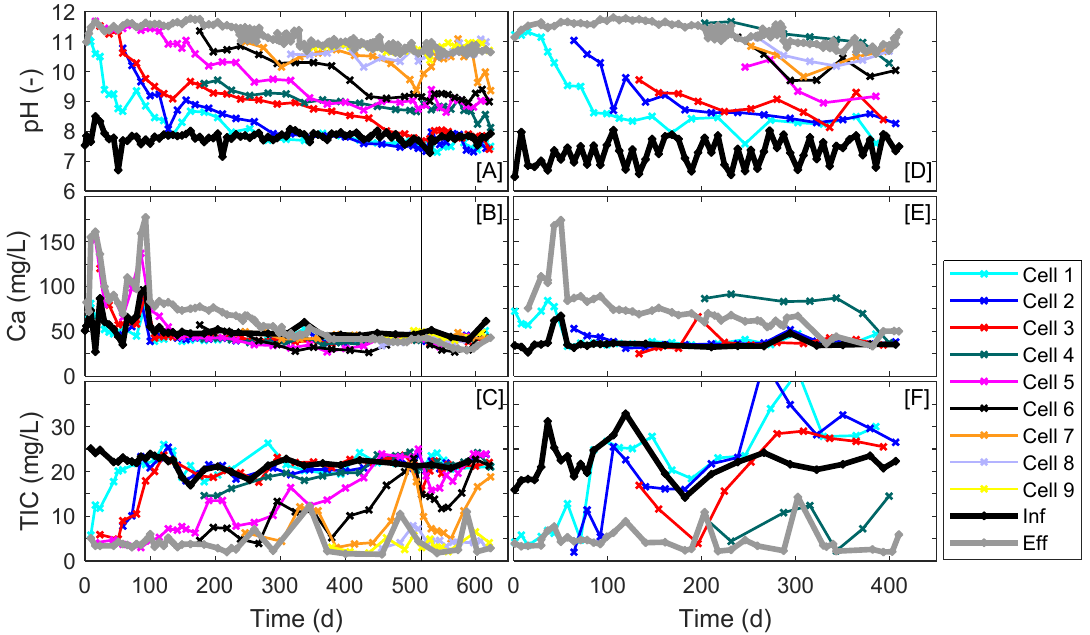
Figure 2. Water composition in columns 1 ( A – C ) and 2 ( D – F ). The influent flow rate of column 1 was reduced from 6.9 ± 1.3 mL/min to 3.4 ± 0.5 mL/min at time 517 d (indicated by a vertical line). Note